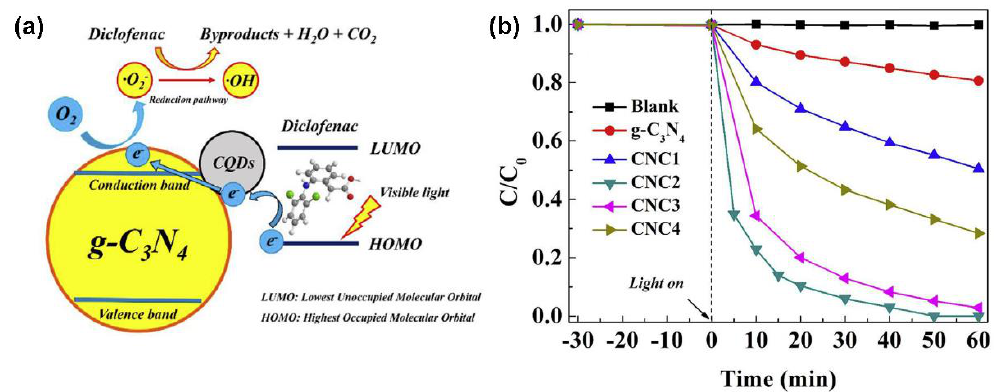
Figure 10. ( a ) Schematic illustration showing the visible light-induced photocatalytic degradation of organic compounds over CQD-modified g-C 3 N 4 . ( b ) Photocatalytic degradation kinetics of diclofenac by different photocatalysts. Adapted with permission from Reference [155]. Copyright (2019) Elsevier.